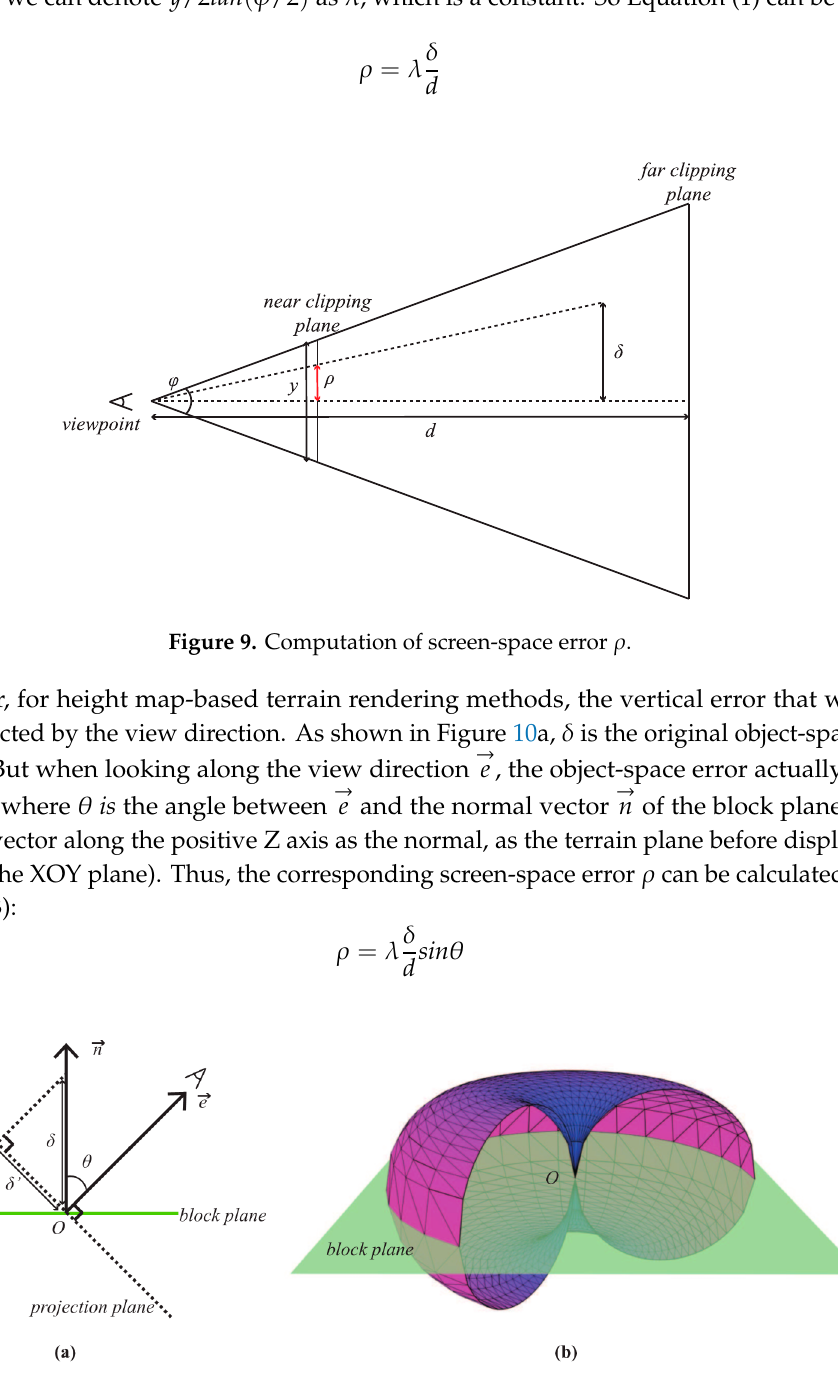
Figure 10. View-dependent error metric: ( a ) View direction affects the object-space error. ( b ) Geometric representation of the boundary condition of node splitting.